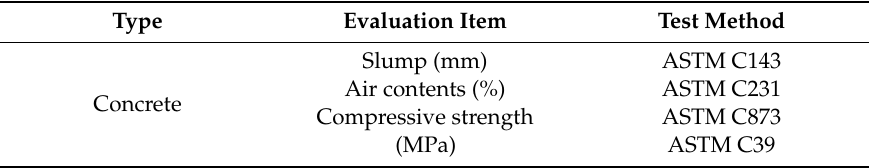
Table 5. Test methods for fresh and hardened properties of